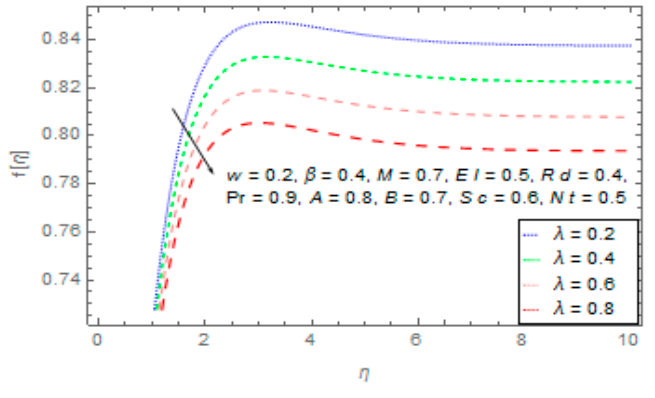
Figure 2. Influence of λ on velocity profile. Applied sciences 2018 , 17 , x FOR PEER REVIEW